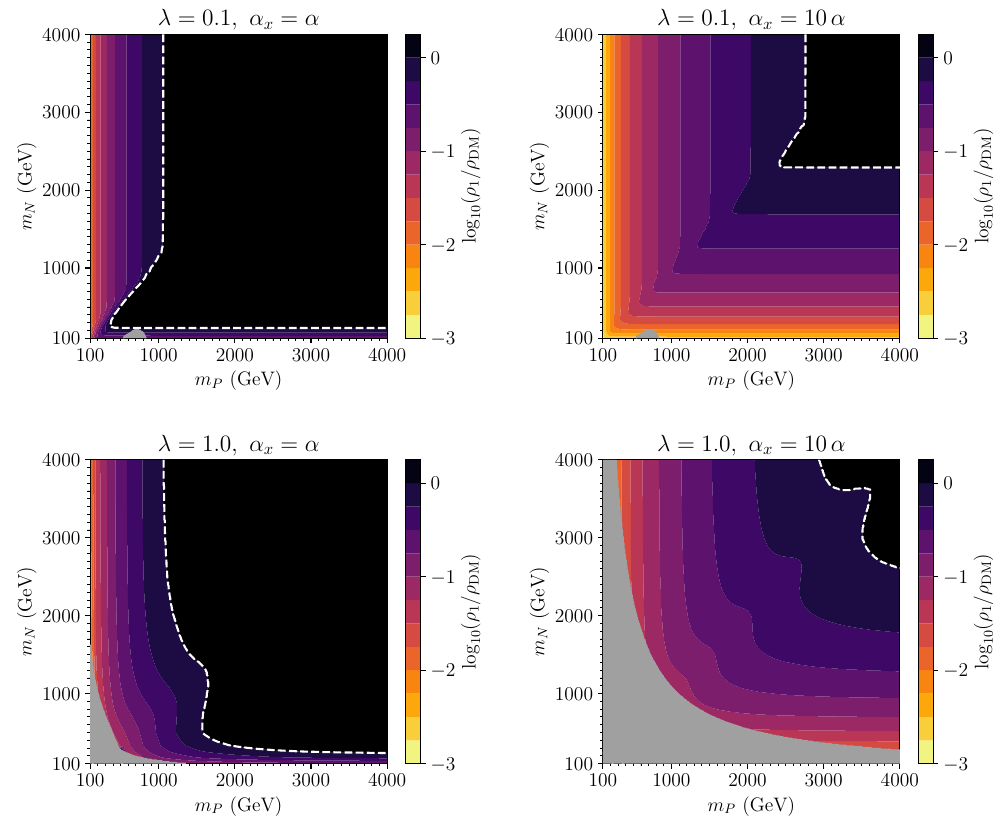
Figure 2 . Fractional relic densities ρ 1 /ρ DM of the ψ 1 connector fermion for λ = 0 . 1 (top) and λ = 1 . 0 (bottom) with α x = α (left) and α x = 10 α (right). The grey shaded regions show the combined exclusions from direct searches while the black shaded regions indicate where ψ 1 produces too much thermal dark